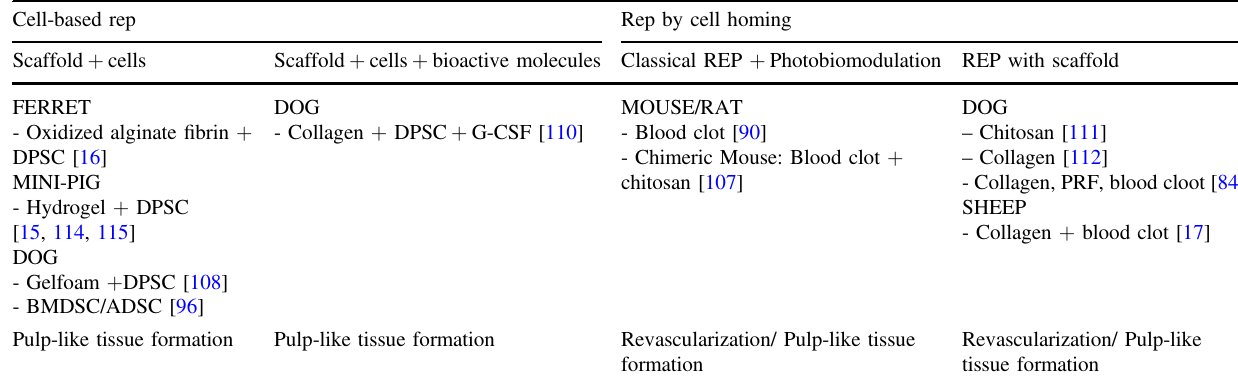
Table 5 Orthotropic models for regenerative endodontic treatment of necrotic teeth Cell-based rep Rep by cell homing Scaffold +